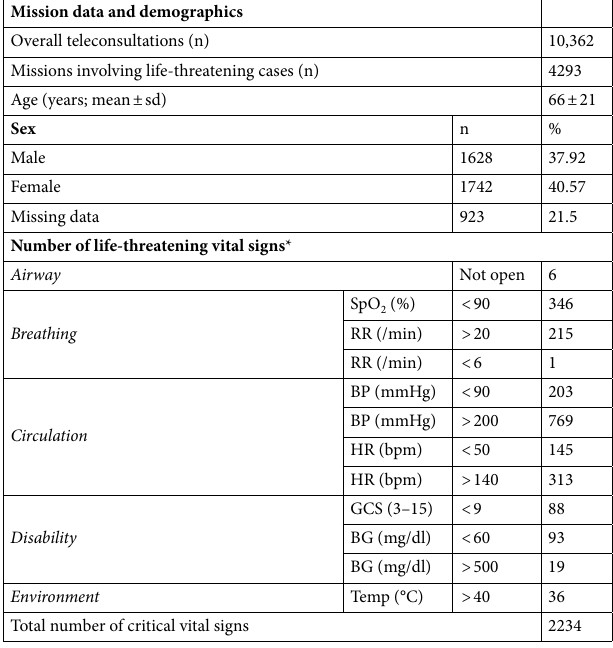
Significant improvement in vital